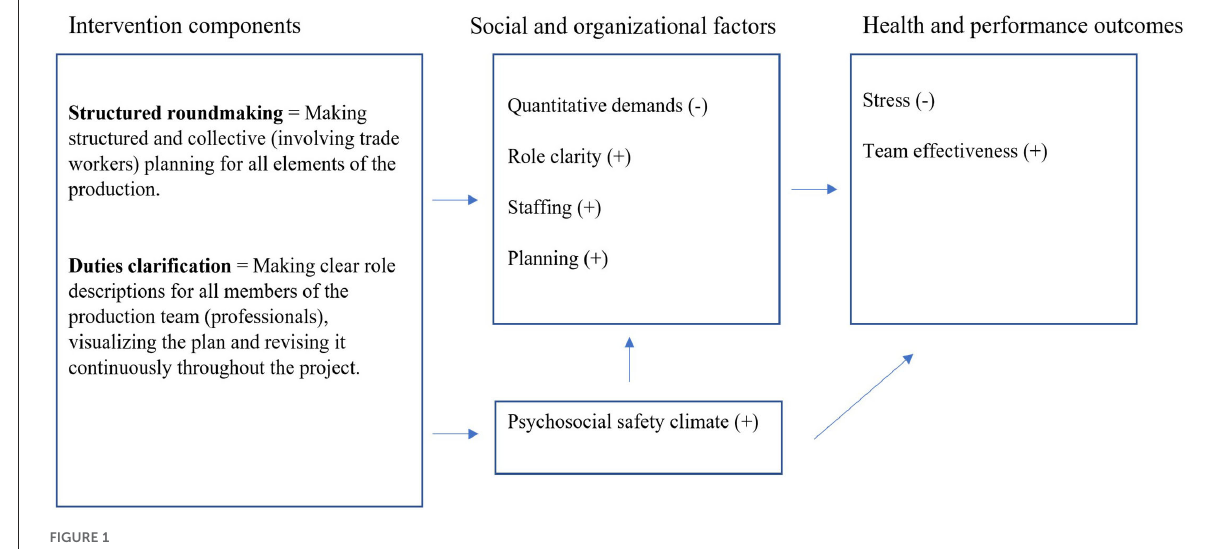
FIGURE1 Program logic of expected order of change